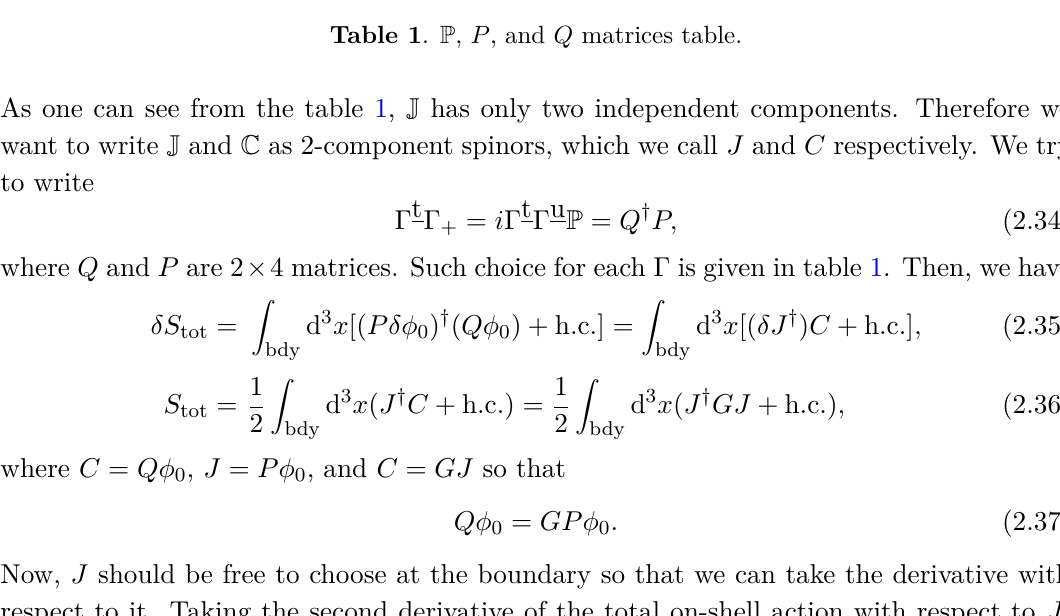
Table 1 . P , P , and Q matrices